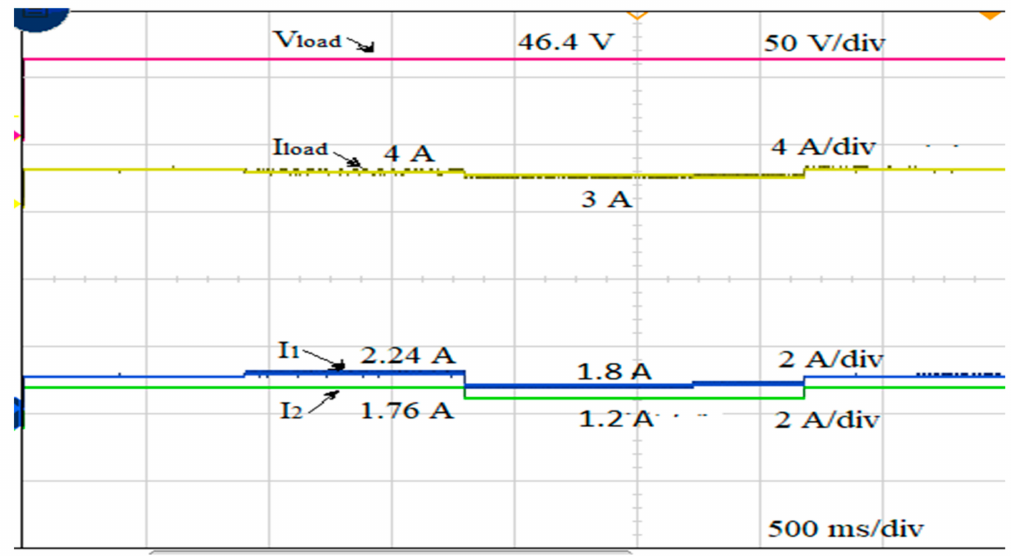
Figure 18. Experimental results for variation in source voltage and load with different cable resistances for the novel droop